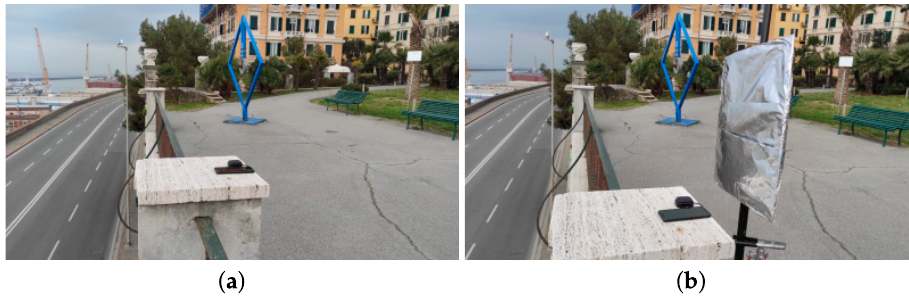
Figure 2. Test 2 acquisition under standard condition ( a ), and with multipath induced ( b